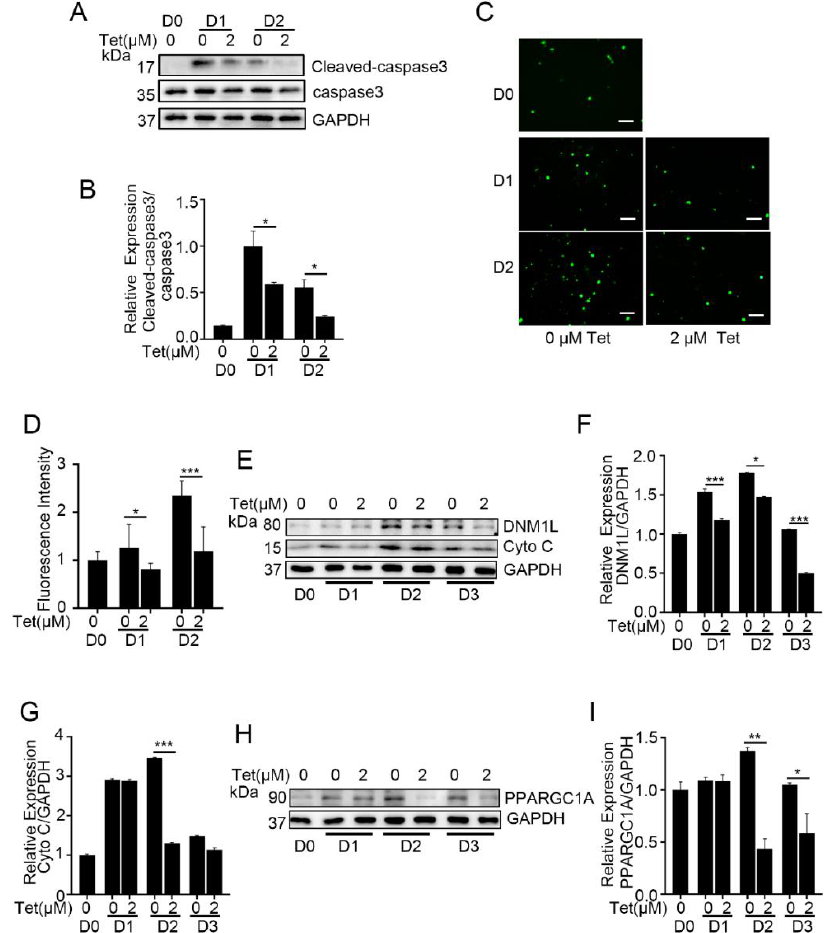
Figure 5. Tetrandrine inhibits mitochondrial remodeling in C2C12 cells during